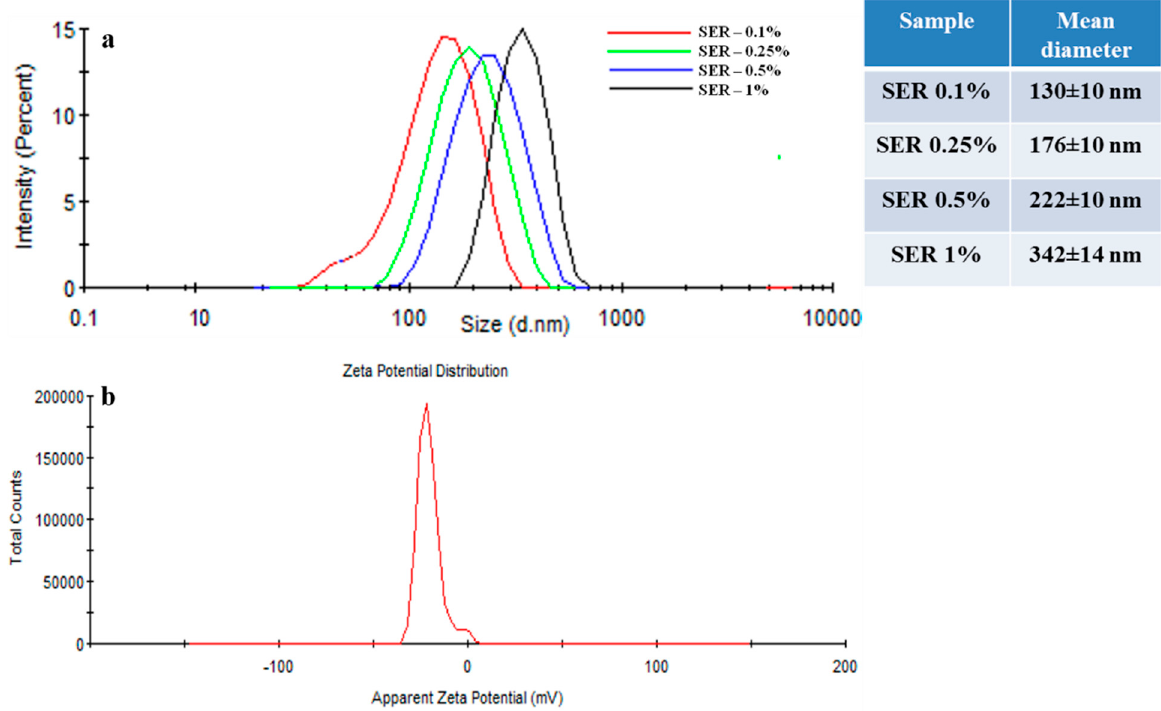
Figure 8. DLS dimensional distribution of sericin nanoparticles with various concentrations ( a ); DLS zeta potential of sericin nanoparticles—SER 0.1% formulation ( b ) .